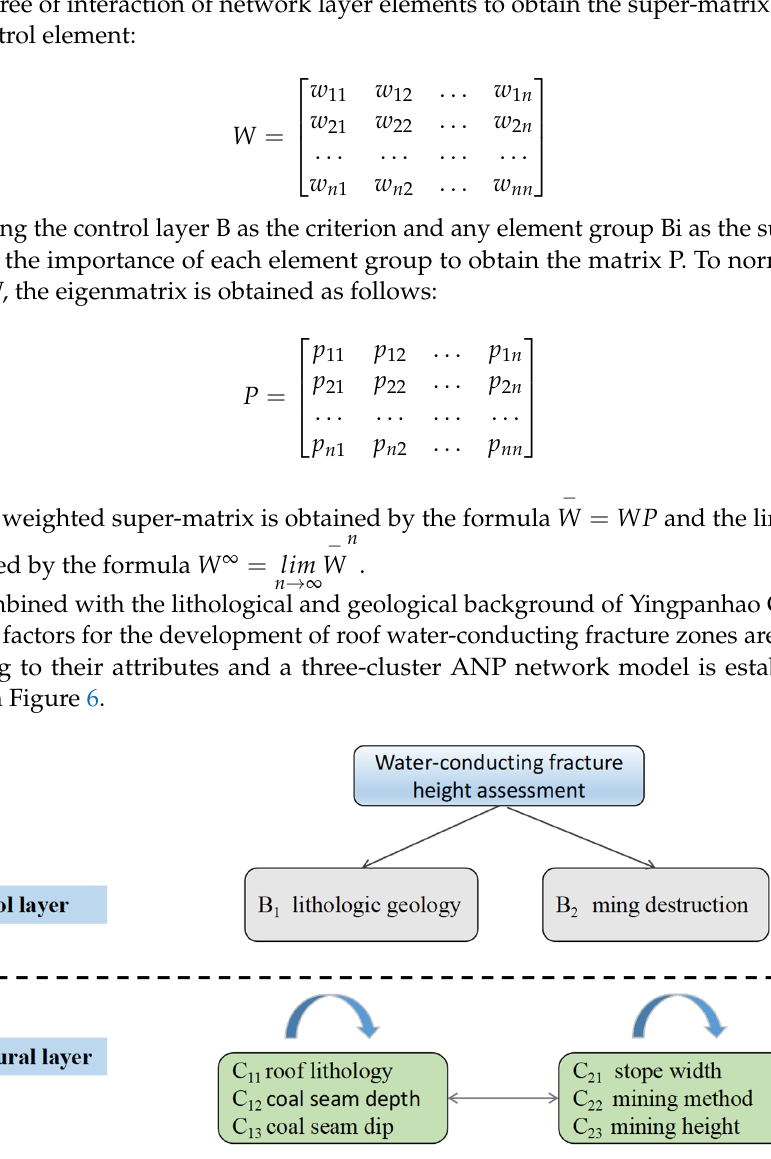
Figure 6. ANP model of water-rich controlling factor. The calculation results